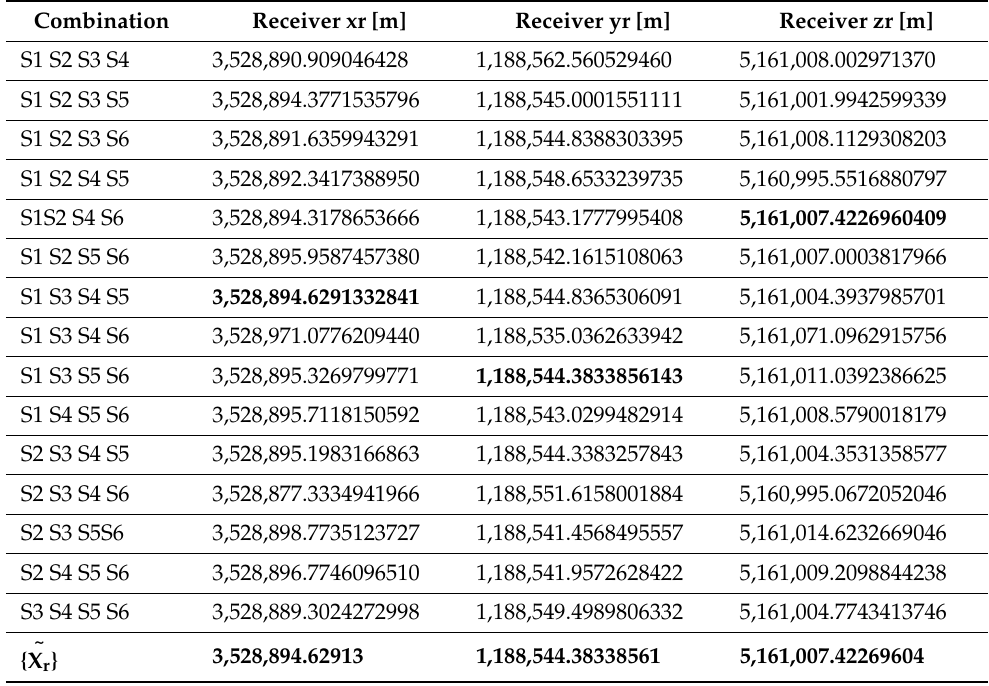
Table 2. Receiver coordinates for different satellite